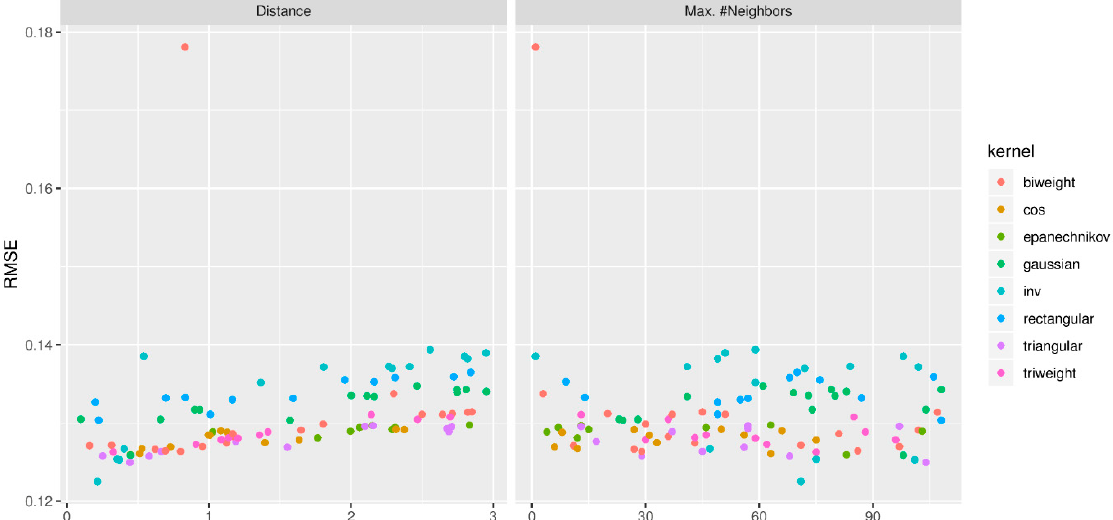
Figure 11. Performance of the k -nearest neighbors (kNN) model in this study.